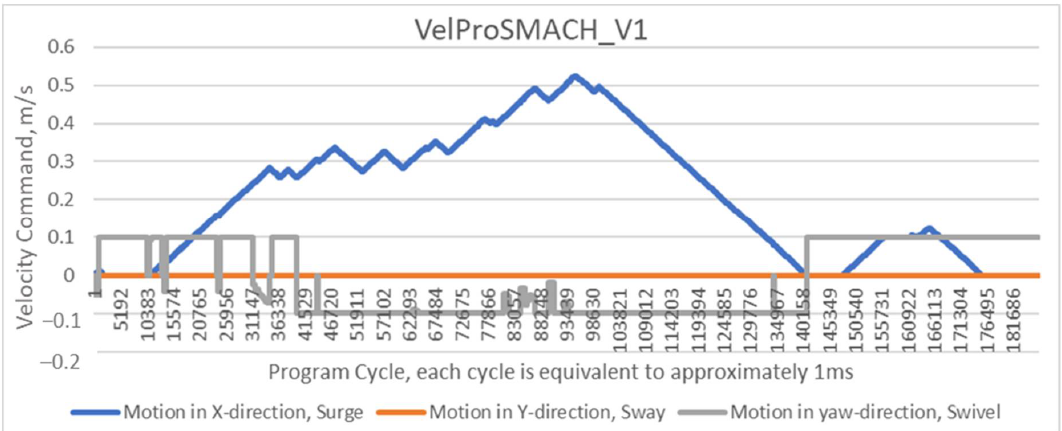
Figure 3. Ramp velocity profile from VelProSMACH_V1.